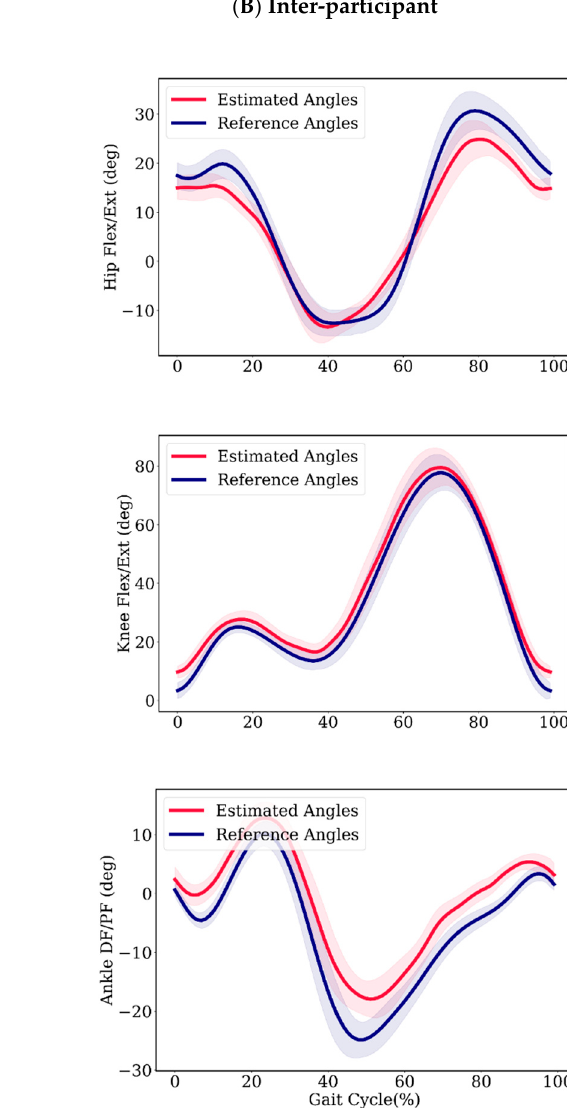
Figure 5. Average estimated and reference angles of participant 7 with standard deviations in shadow for ( A ) intra-participant model and ( B ) inter-participant model. Flexion (Flex) / Dorsiflexion (DF) are positive; extension (Ext) / Plantarflexion (PF) are negative.